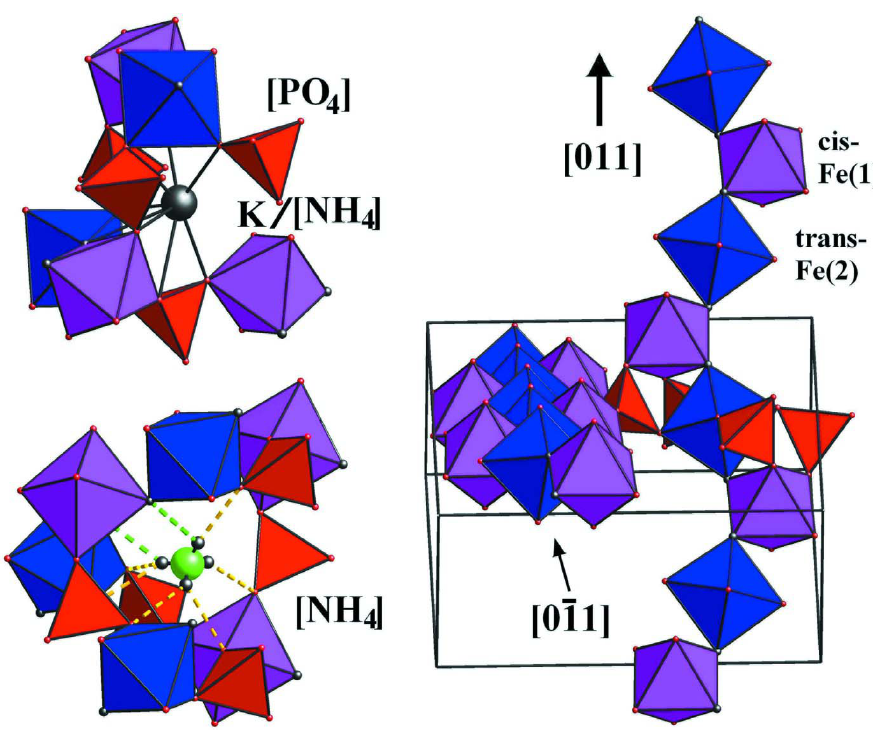
Figure 2 Left: (1). Coordination environment of eight coordinated potassium/ammonium ions(upper); (2). Coordination environment of ammonium ions via hydrogen bonds(down).Right: chains built up of alternate trans -[FeO F ] octahedra running along [011] and [0-11] cis -[FeO 4 2